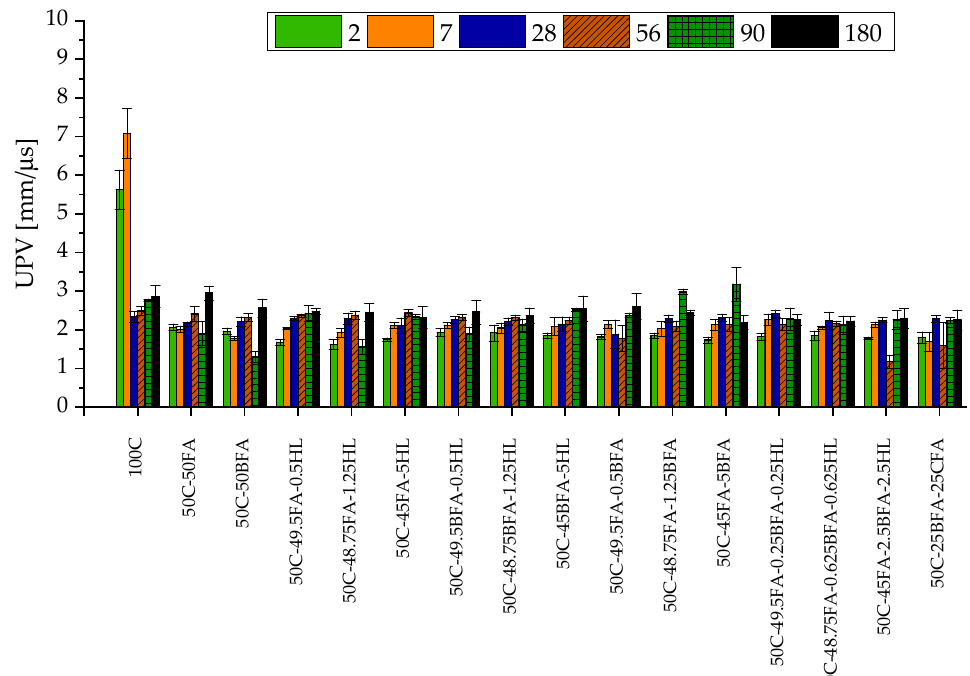
Figure 2. UPV values from the direct method for the different mortar formulations for 2, 7, 28, 56, 90, and 180 of curing.